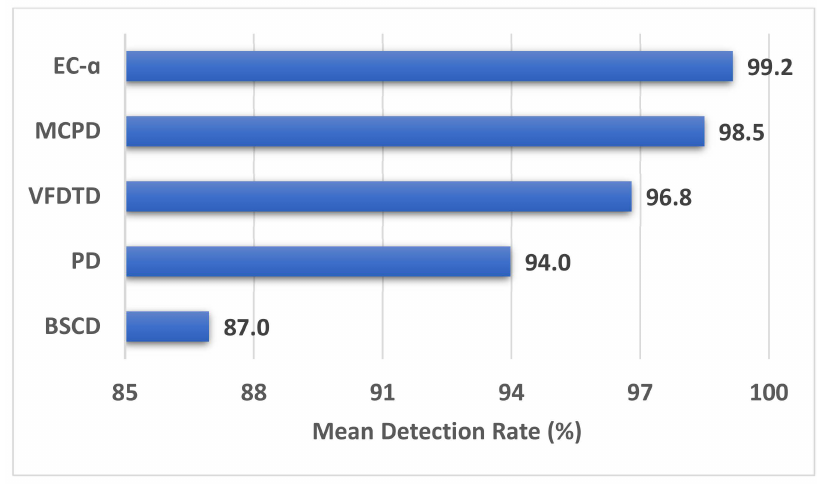
Figure 7. Overall transient starting point detection accuracy of the methods at low SNR.